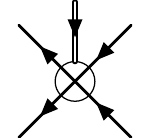
Figure 7 . Length-two two-particle tree-level form factor diagram.